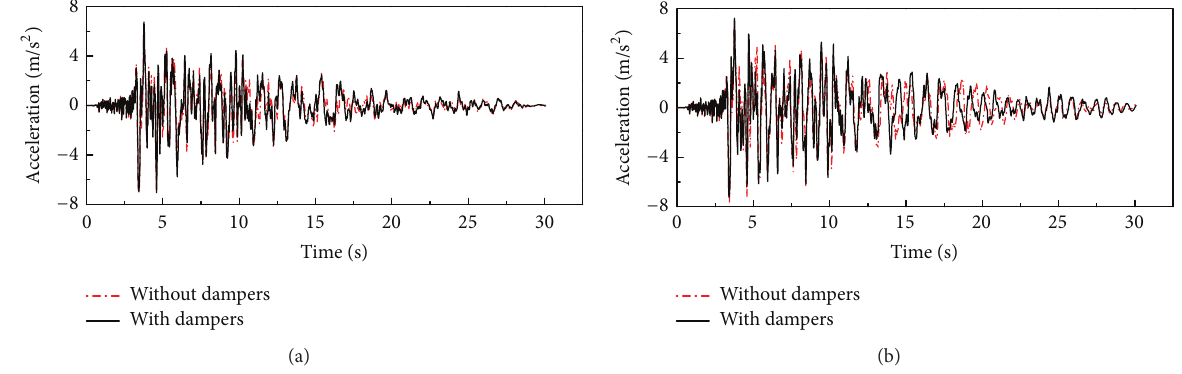
Figure 11: Time histories of the acceleration of the bridge deck: (a) longitudinal direction; (b) transverse direction.